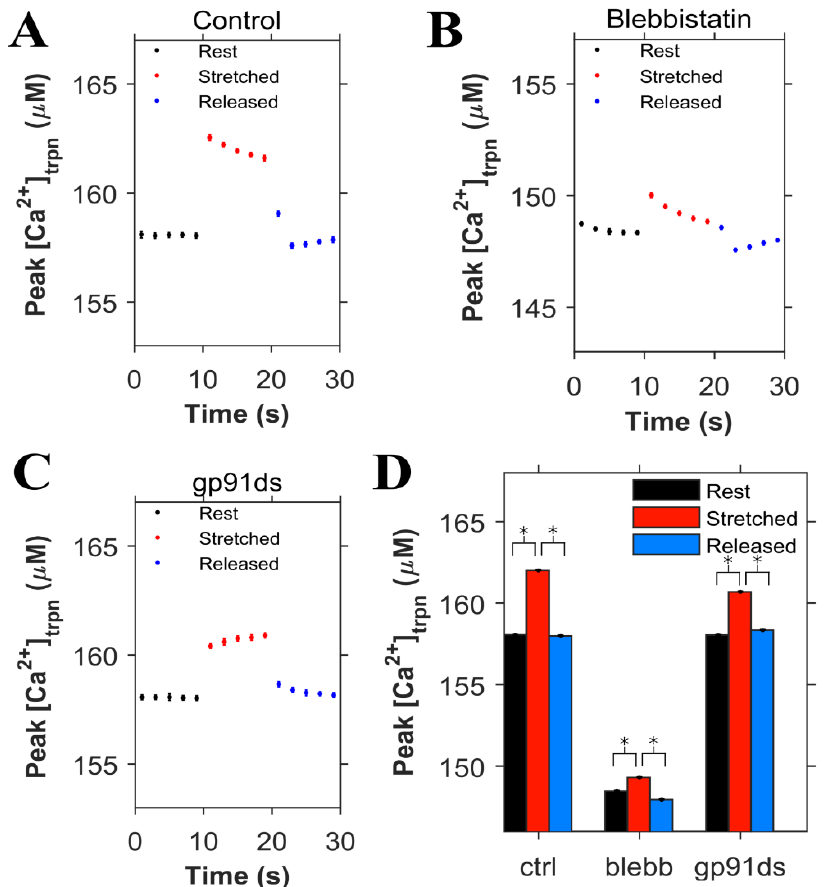
Figure 6 . Simulation results (n = 20 simulations) for cardiomyocytes paced at 0.5 Hz (same simulations as Figure 5). The peak value of Ca 2+ bound to troponin ([Ca 2+ ] trpn ) is shown when the cardiomyocyte is at rest (black), stretched (red) and released after the stretch (blue). A . Under control condition. B . When blebbistatin is used which inhibits the actin myosin bridge. C . When gp91ds is used which inhibits NOX2 from producing stretch-dependent ROS. D . The calculated corresponding average of peak ([Ca 2+ ] trpn ) under each subgroup (rest, stretched and released) in each group (control, blebbistatin and gp91ds). * p < 10 − 22 .